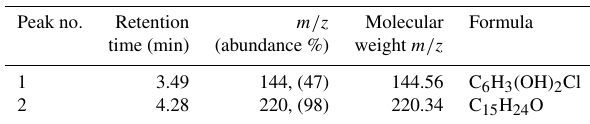
Table 2. The final degradation products indicated by GC-MS. Peak no.